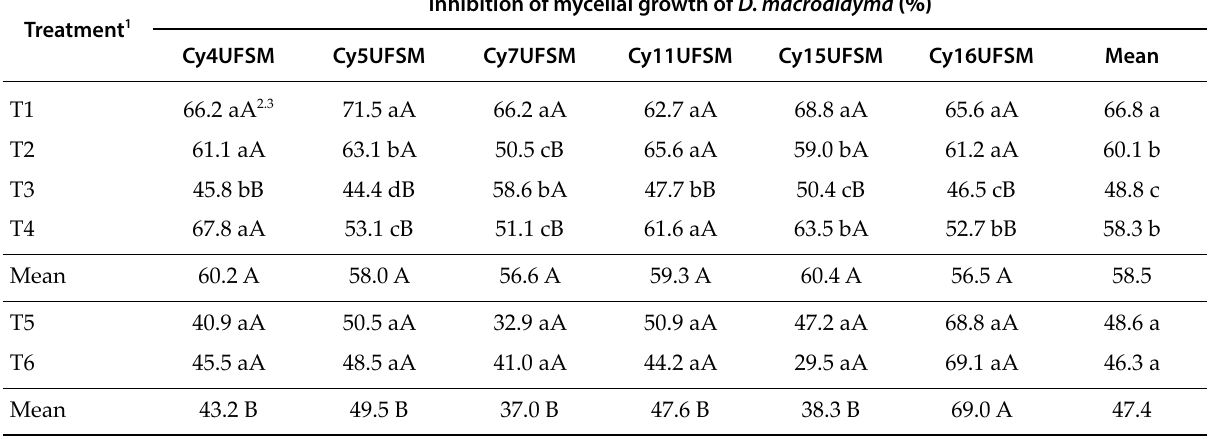
Table 3. Mean inhibition of mycelial growth (%) of isolates of Dactylonectria macrodidyma exposed to volatile metabolites of Trichoderma spp. and Bacillus subtilis in vitro . Treatment